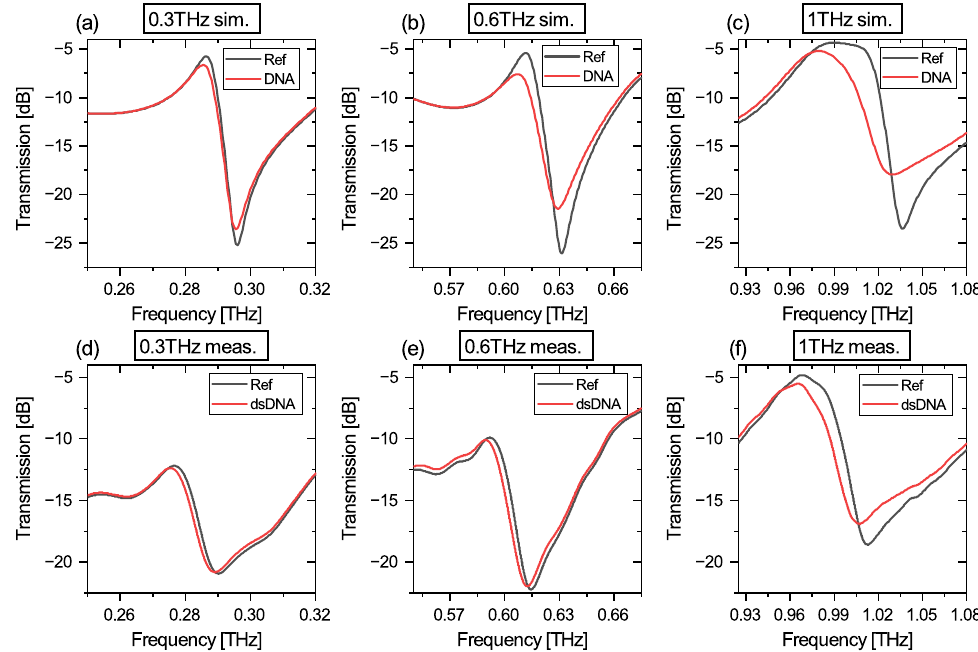
Figure 3. Comparison of simulation (upper row) and measurement results (bottom row). For each diagram, the reference is indicated in black and for DNA in red. ( a ) shows the simulation result for 0.3THz biosensors, ( b ) for 0.6THz and ( c ) for 1THz. The measurement results of the biosensors are shown for ( d ) 0.3THz, ( e ) 0.6THz and ( f ) for